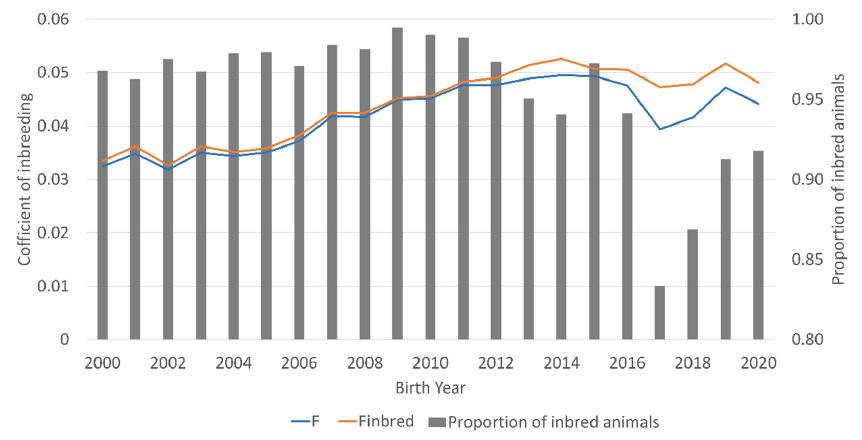
The proportion of inbred animals in the DD reference population fluctuated between 94.1 and 99.5% in the birth years 2000 to 2016 and decreased in the following birth year to 83.3%, followed by an increase to 91.8% in 2020 (Figure 1). The mean coefficient of